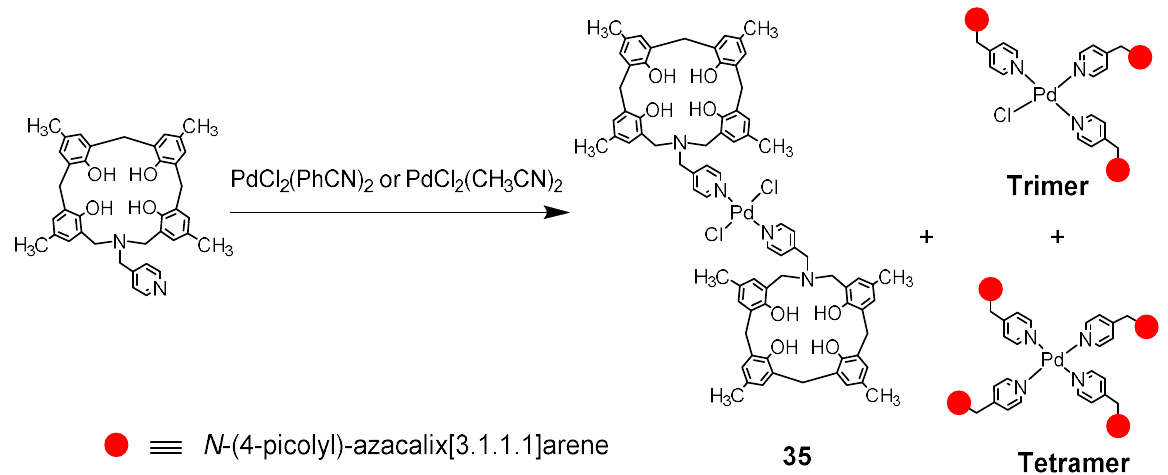
20 of 27 Figure 11. Molecular structure of xylylene-bridged N -(4-picolyl)-azacalix[3.1.1.1]arene 33 . Two Br − are omitted for